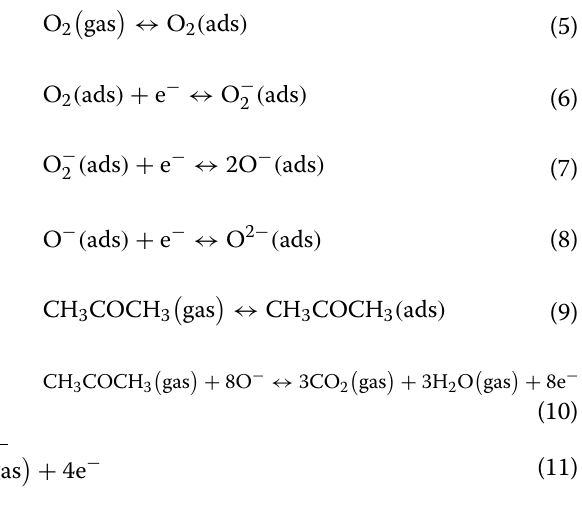
Table 1 Comparison of various TiO Sensing materials